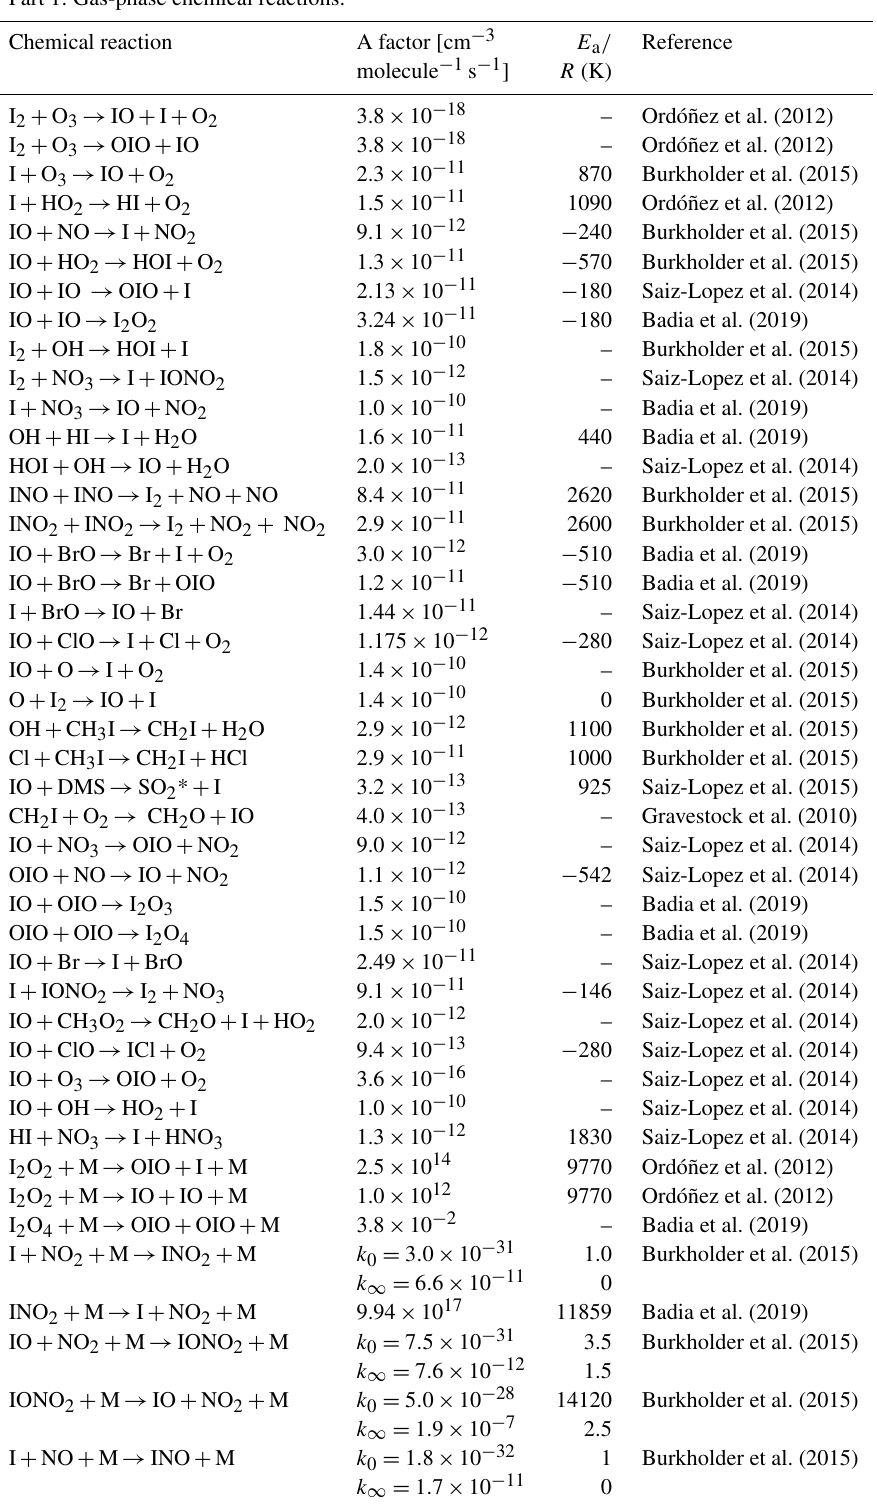
Table 3. The list of chemical reactions with iodine included to SOCOL-AERv2-I. Part 1: Gas-phase chemical